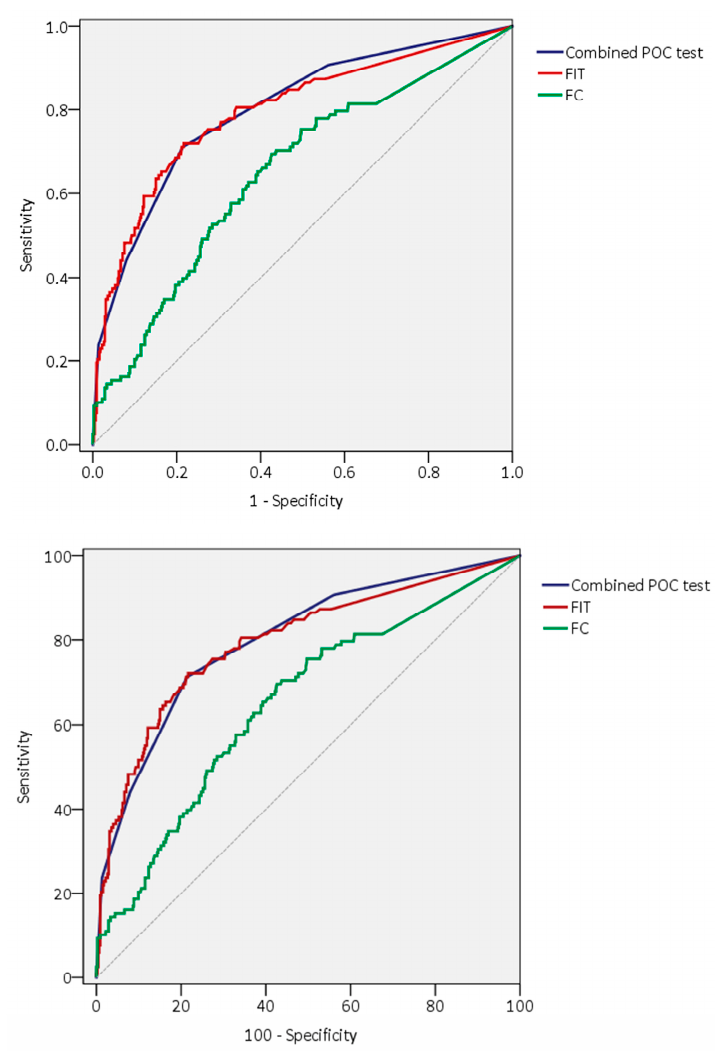
Figure 2. Receiver operation curves of FIT, FC, and the four-biomarker combined POC faecal test for the diagnosis of significant colonic pathologies.